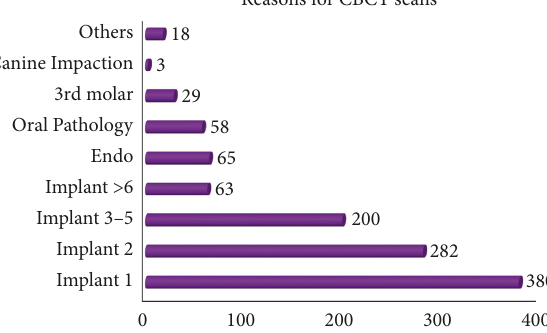
Figure 3: Reasons for CBCT scans. The numbers beside the bars represent the patient counts in each CBCT scan